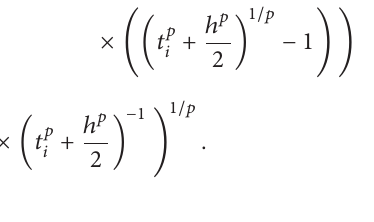
method with the 2